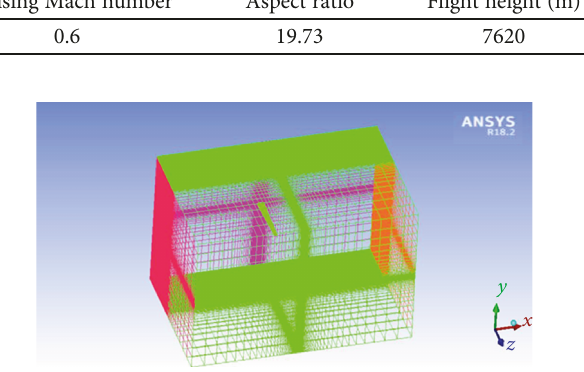
Figure 1: Structural mesh of NACA